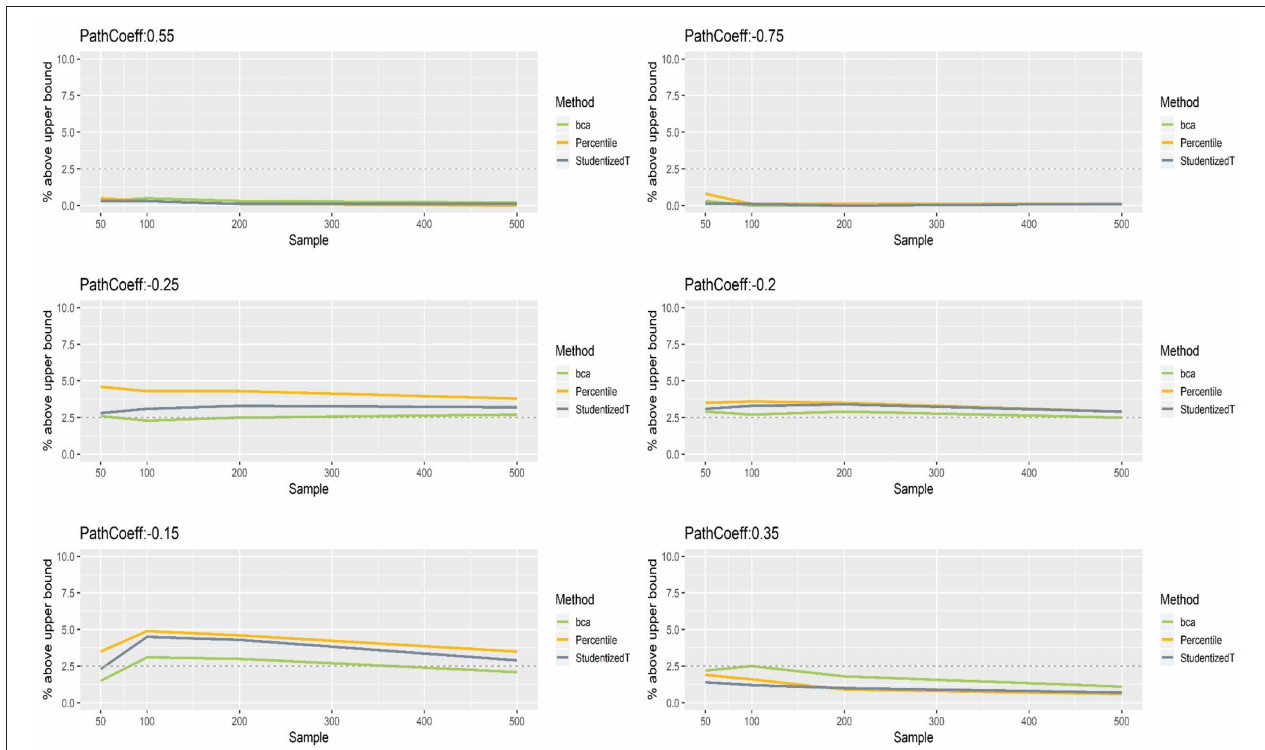
FIGURE 9 | The upper limits of percentile, bias-corrected and accelerated bootstrap (BCa), and Student’s t 95% confidence intervals (CIs) of path coefficients in the non-normally distributed indicator condition.